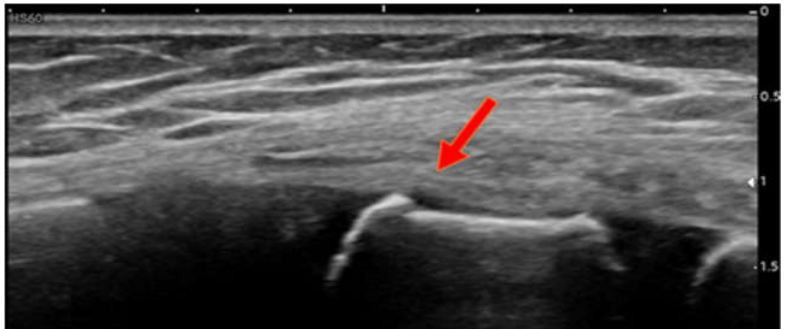
Figure 1. Case 1, fracture of caudal manubrium sterni.